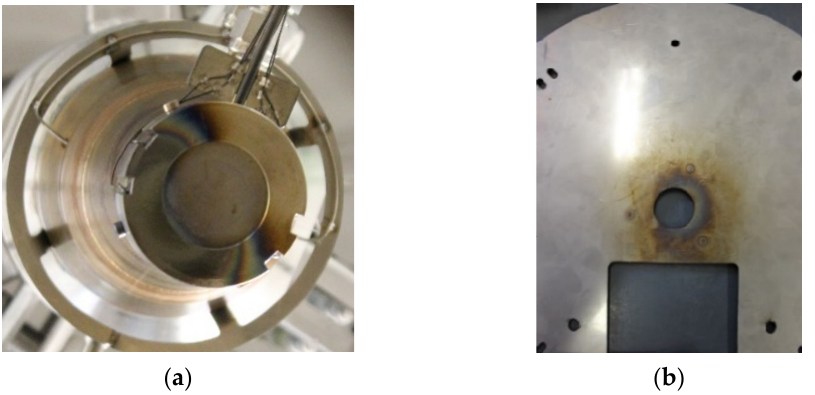
Figure 13 . Status of the laser-heated surface after the first series of tests: ( a ) mock-up surface—the dark-gray area indicates that the load was applied eccentrically, only partially heating the tungsten armor as intended, wherein a significant part of the load is applied to the steel ring holding the armor; ( b ) shielding plate’s surface is heated on the other part.